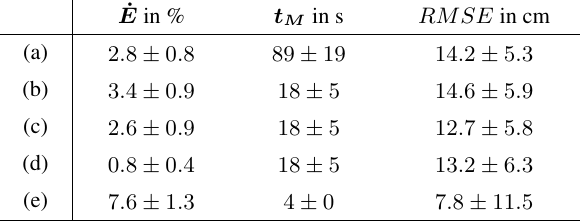
Table 2: Failure rate ˙ E , matching time t M , and geometrical ac- curacy of coarse alignment (RMSE) of indoor Office data